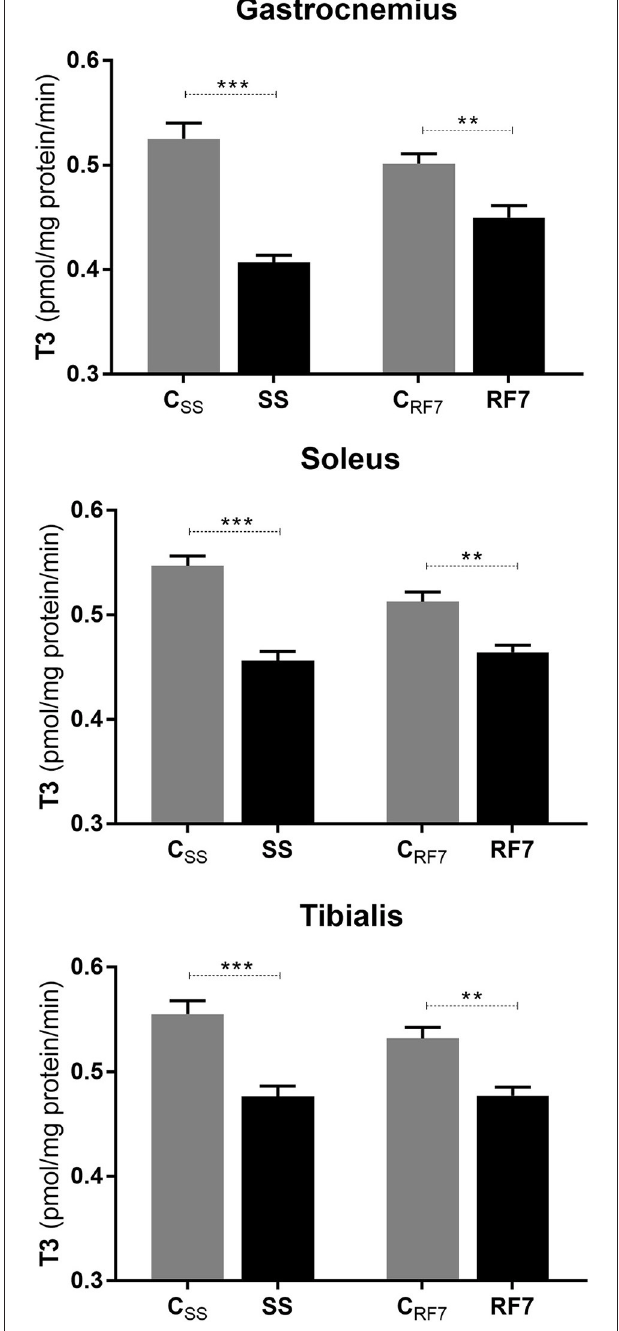
FIGURE 3 | Net T3 formation from its T4 precursor in Gastrocnemius, Soleus and Tibialis anterior muscles from (i) rats semistarved (SS) for 14 days and their controls (C SS ), and (ii) rats refed for 7 days (RF7) and their controls (C RF7 ). The values are mean ± SE ( n = 6). Statistical significance of differences are indicated as follows: ** p < 0.01; *** p < 0.001.